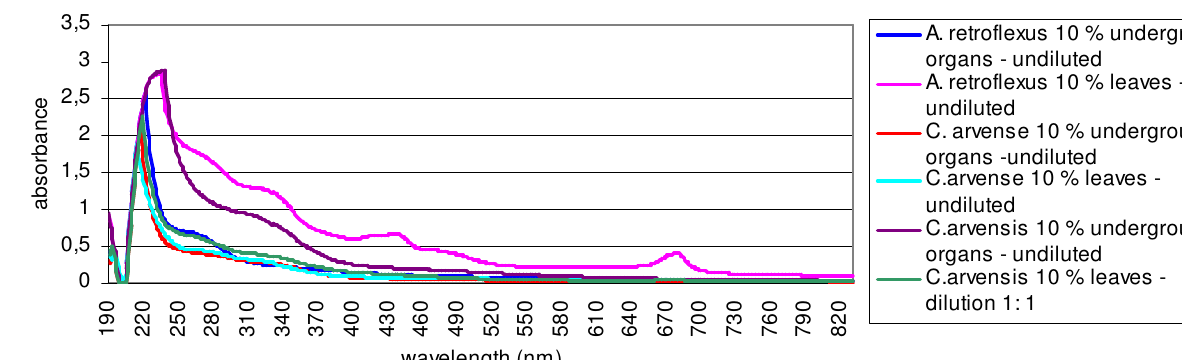
Fig. 1. Absorption spectra for tested extracts of dicotyledonous weeds